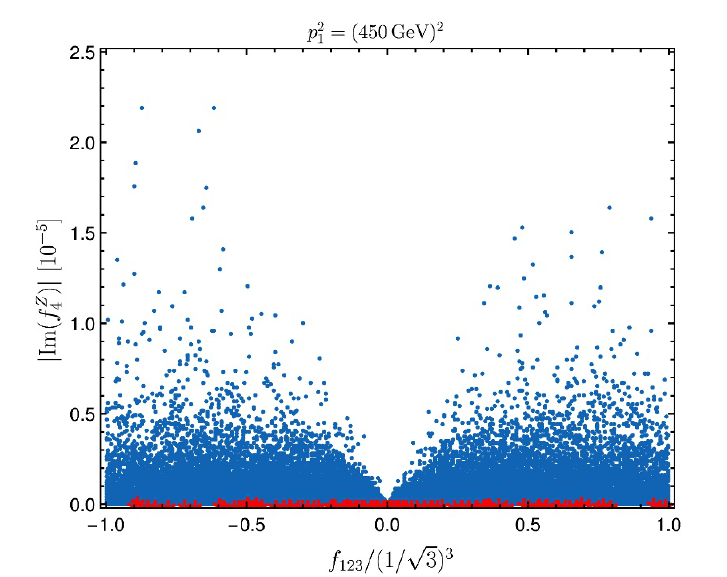
Figure 6. Scatter plot for the imaginary part of f Z function of the combined Z -scalars coupling f 123 , divided by its maximum possible value of (1 = p 3) 3 . The external Z boson 4-momentum is p 2 the dark neutral scalars are smaller than 200 GeV, m h